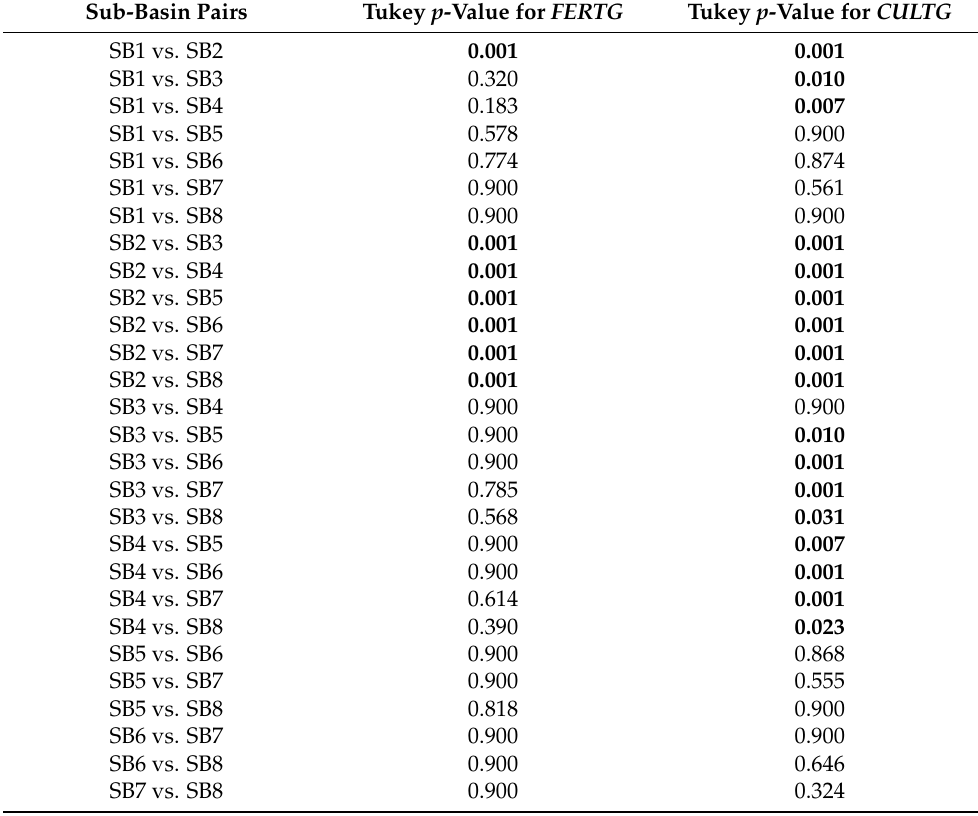
Table 3. Tukey Honestly Significant Difference (HSD) results for FERTG and CULTG components. p -values lower than 0.05 highlighted in